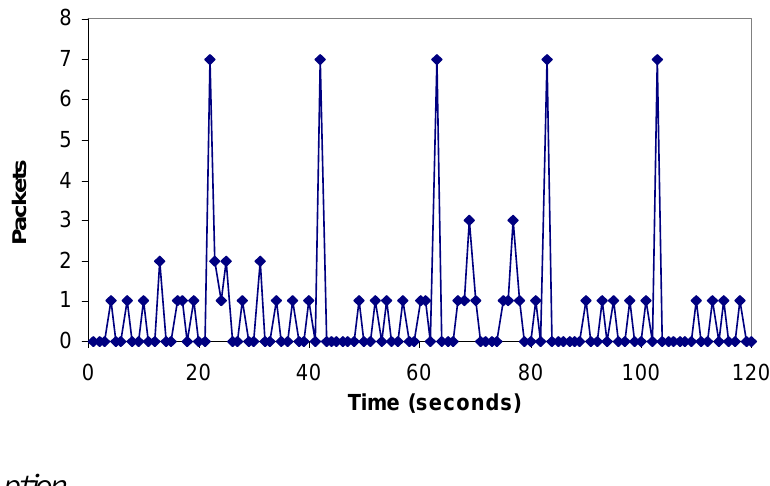
Figure 19. Packets per second when there is an